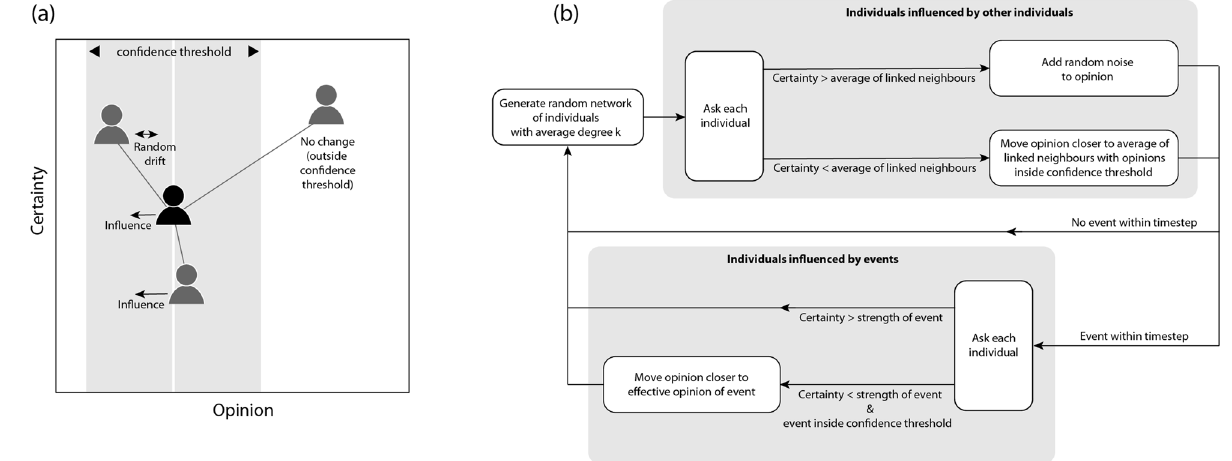
Figure 1. ( a ) Conditions under which individuals are influenced; and ( b ) workflow within each model timestep. Note that homophily is a system characteristic and hence confidence threshold is the same for all individuals, whereas certainty varies between